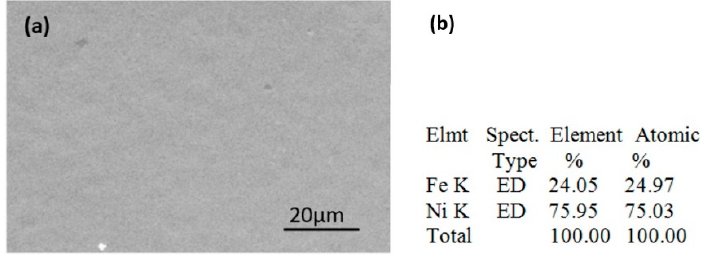
Figure 1. ( a ) Surface morphology and ( b ) Energy Dispersive X-ray Spectroscopy (EDS) result of as-deposited FeNi plating.